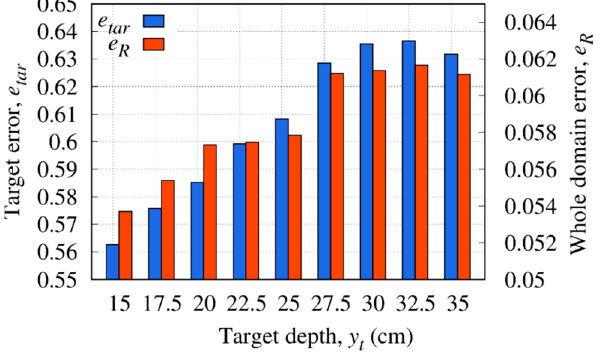
Figure 11. Reconstruction errors in the whole domain and inside the target versus the target size, y t 𝑦 (cid:3047) .